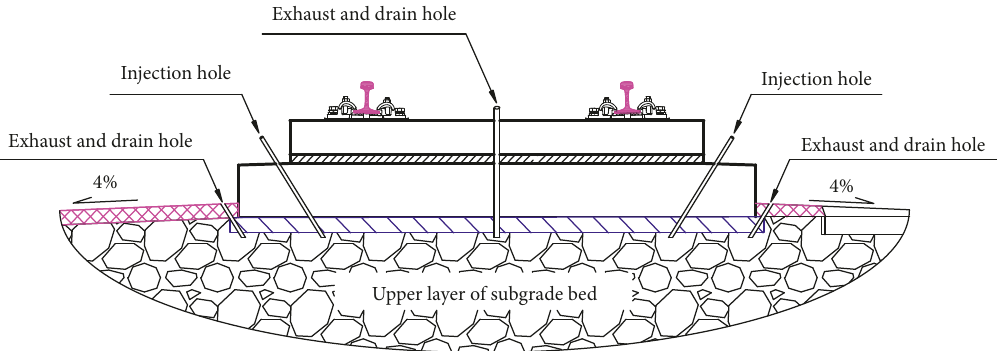
Figure 6: The layout of the injection and exhaust and drain holes in the ballastless track-subgrade.